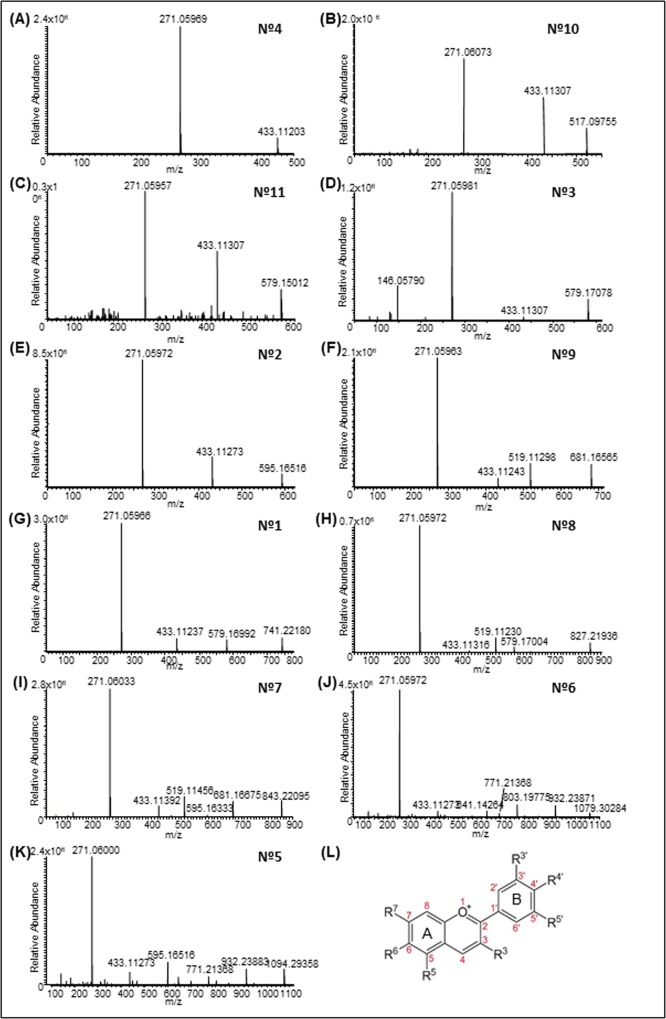
ESI-MS/MS spectra of anthocyanins isolated from petals of Gentiana lutea L. var. aurantiaca.The number from 1 to 11 corresponded with the anthocyanins characterized and listed in Table 1. The image in L corresponded to the basic structure of the anthocyanin molecule.